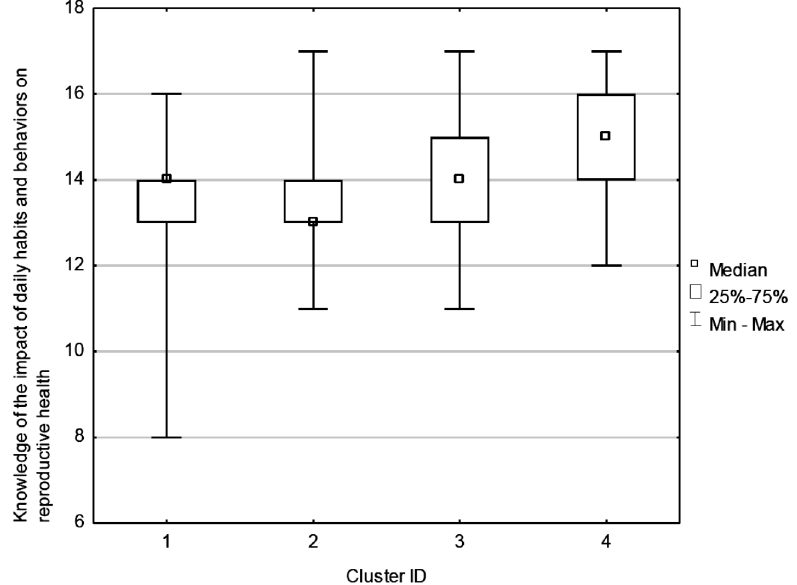
Figure 6. Level of actual knowledge about the impact of everyday behaviour and habits on reproductive